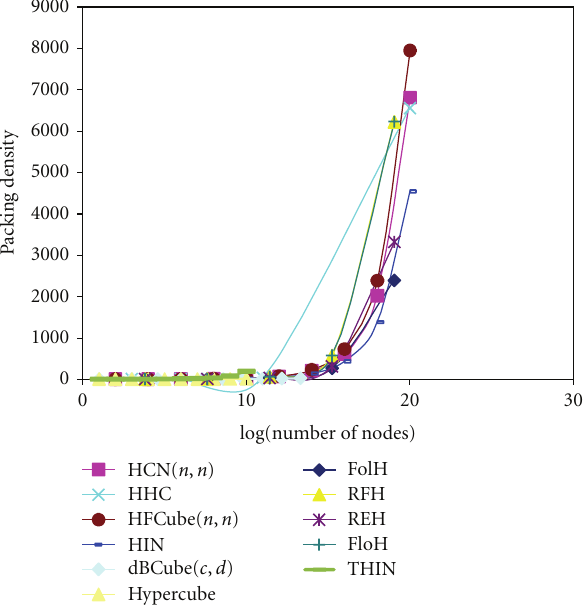
Figure 23: Comparison in terms of the packing density ( = N